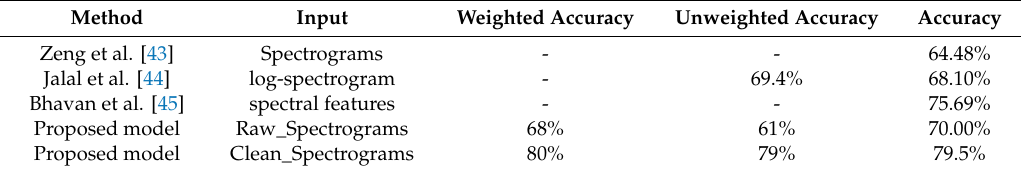
Table 9. Comparison of the proposed method with base line method using RAVDESS dataset.